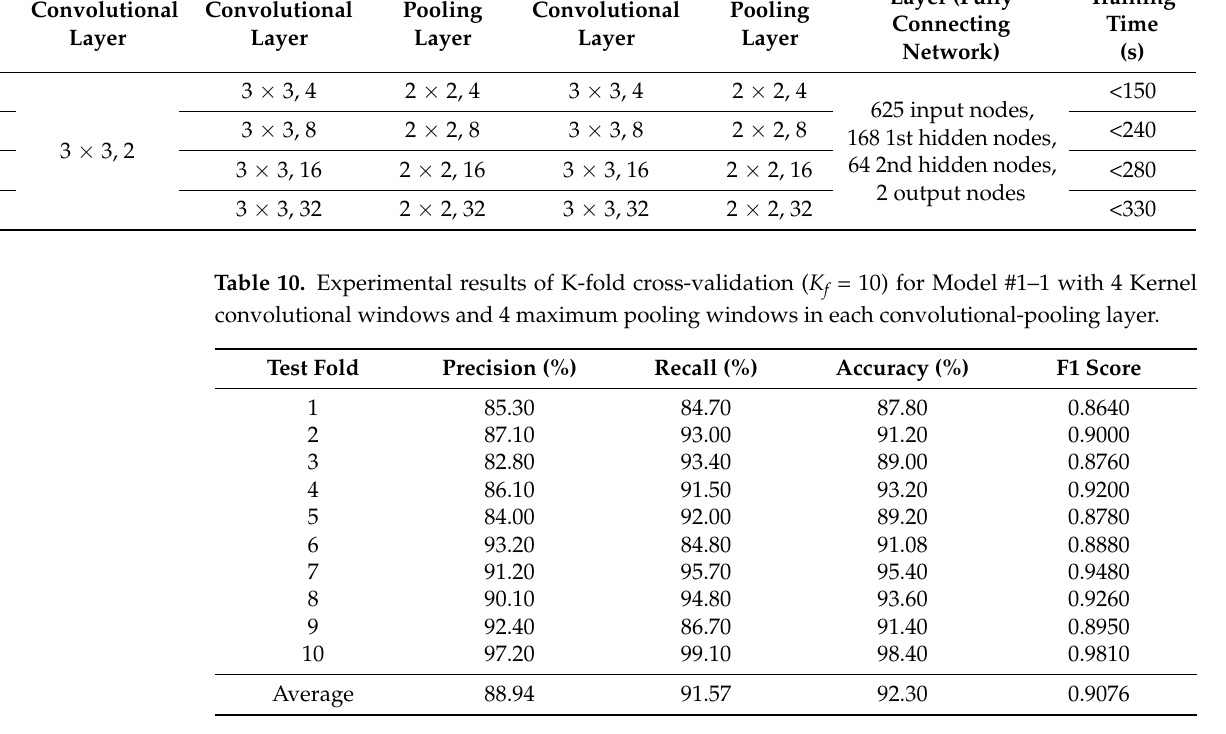
Table 11. Experimental results of K-fold cross-validation ( K f = 10) for Model #1–2 with 8